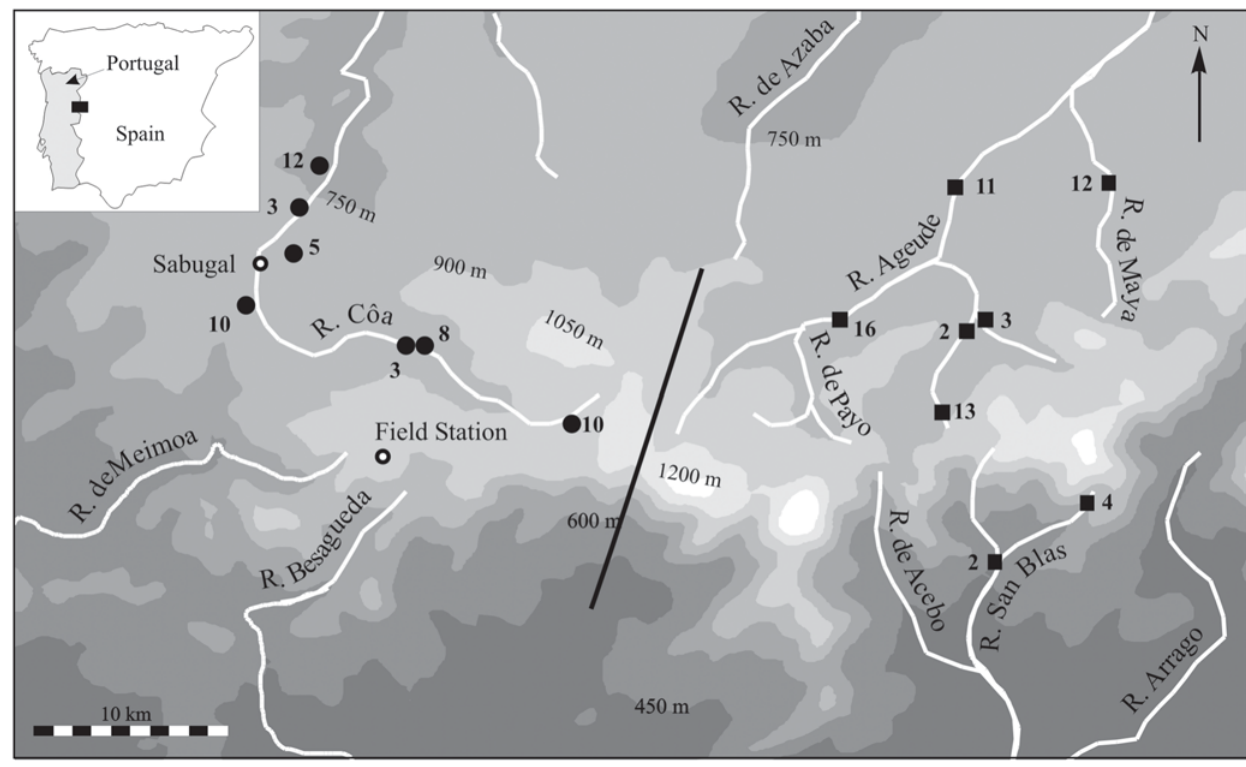
Figure 1. Elevationmap ofsampling localities with samplesizes foreach locality. Filled circles and squares represent sites with MtDNA of the western and eastern lineages respectively, with the centre of the hybrid zone indicated by the black line. The inset shows the position of the study area (black rectangle) on the Iberian Peninsula. Sampling localities are located along rivers (white lines) as the species is almost exclusively riparian.